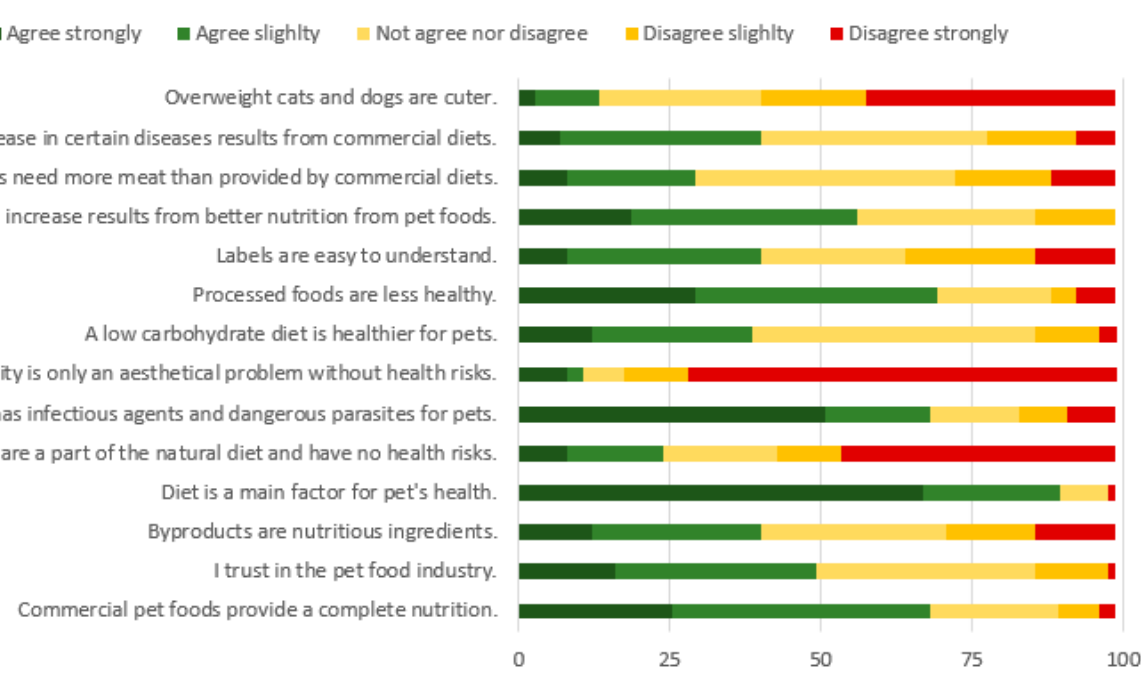
Figure 4. Opinion of Portuguese pet owners on statement regarding pet foods.